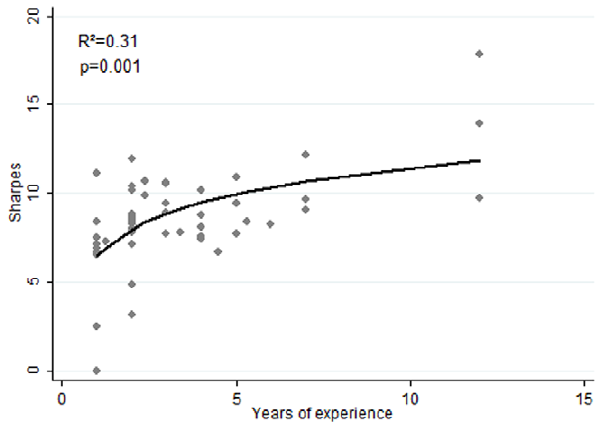
Figure 4. Sharpe Ratio and years of experience. Trader Sharpe Ratios plotted against the number of years they have traded. Sharpe Ratios have been box-Cox transformed. The fitted curve is logarithmic rather than linear. N=53.